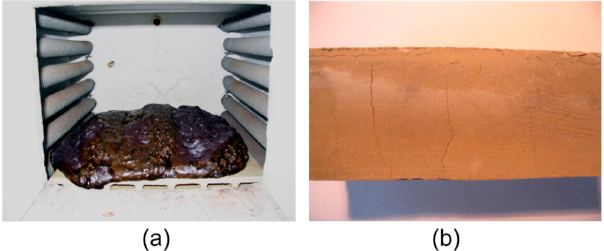
Figure 2. Appearance of FA geopolymer after thermal treatment: ( a ) flushing of FA paste specimens after heating to 1000 °C; and ( b ) transverse cracks on FA paste specimens after heating to 600 °C.